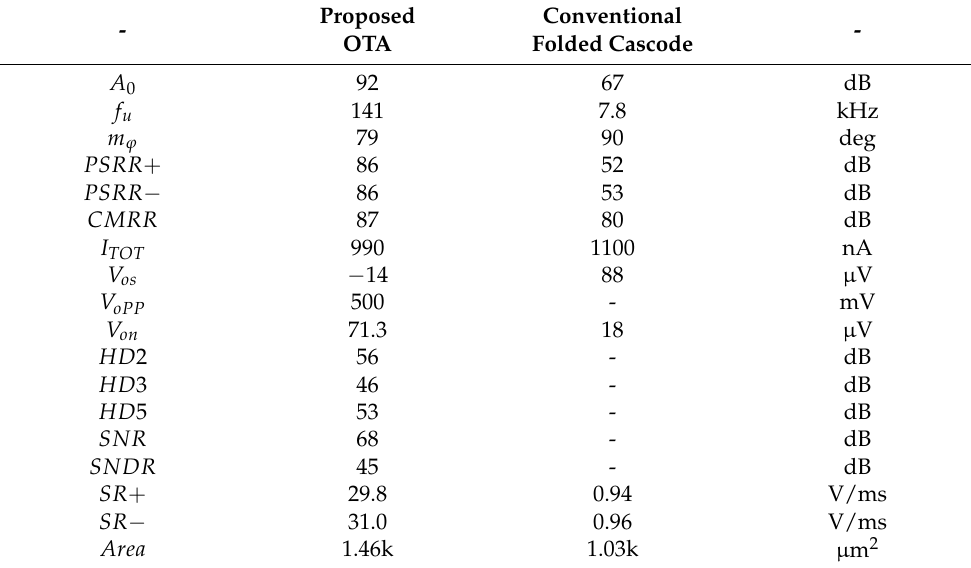
Table 2. Typical 27 ◦ C simulation